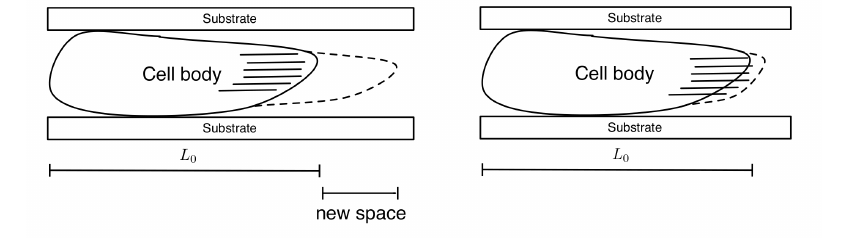
Figure 3. Scheme of the cell domain